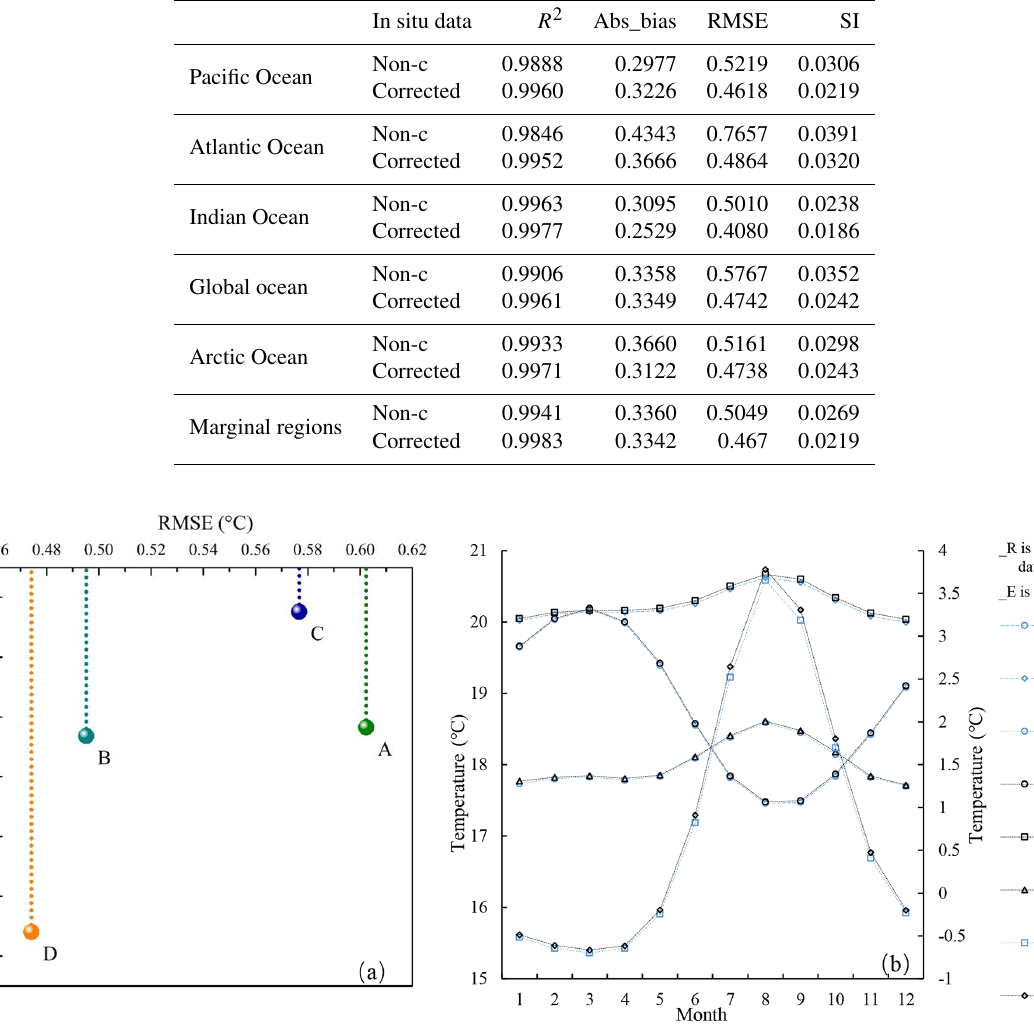
The code for data processing can be downloaded